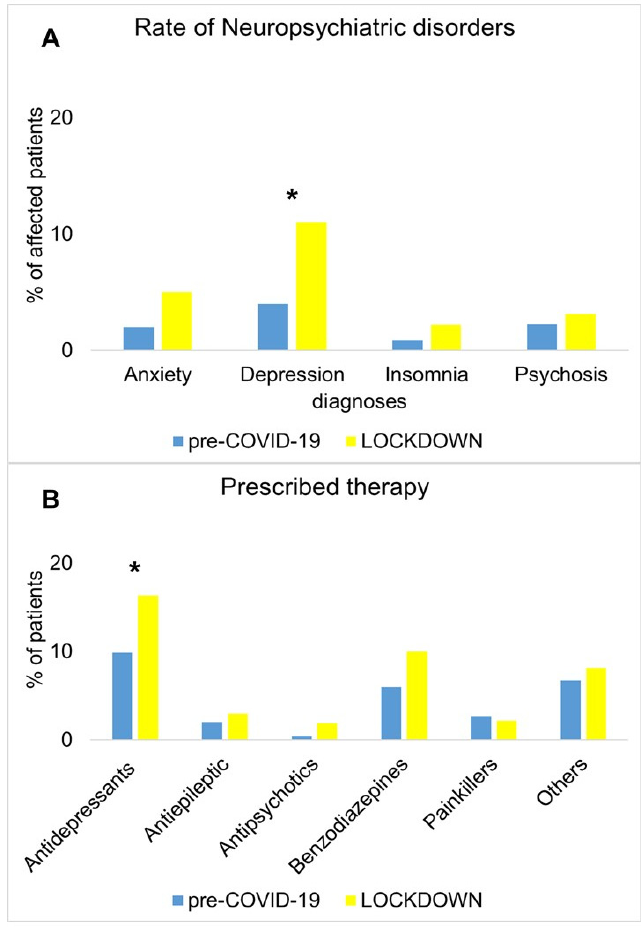
Figure 2. Differences in clinical diagnoses of neuropsychiatric disorders (panel A ) and in prescribed therapy (panel B ) between the pre-COVID-19 group (blue bars) and the LOCKDOWN group (yellow bars). * p < 0.05 was considered statistically significant.